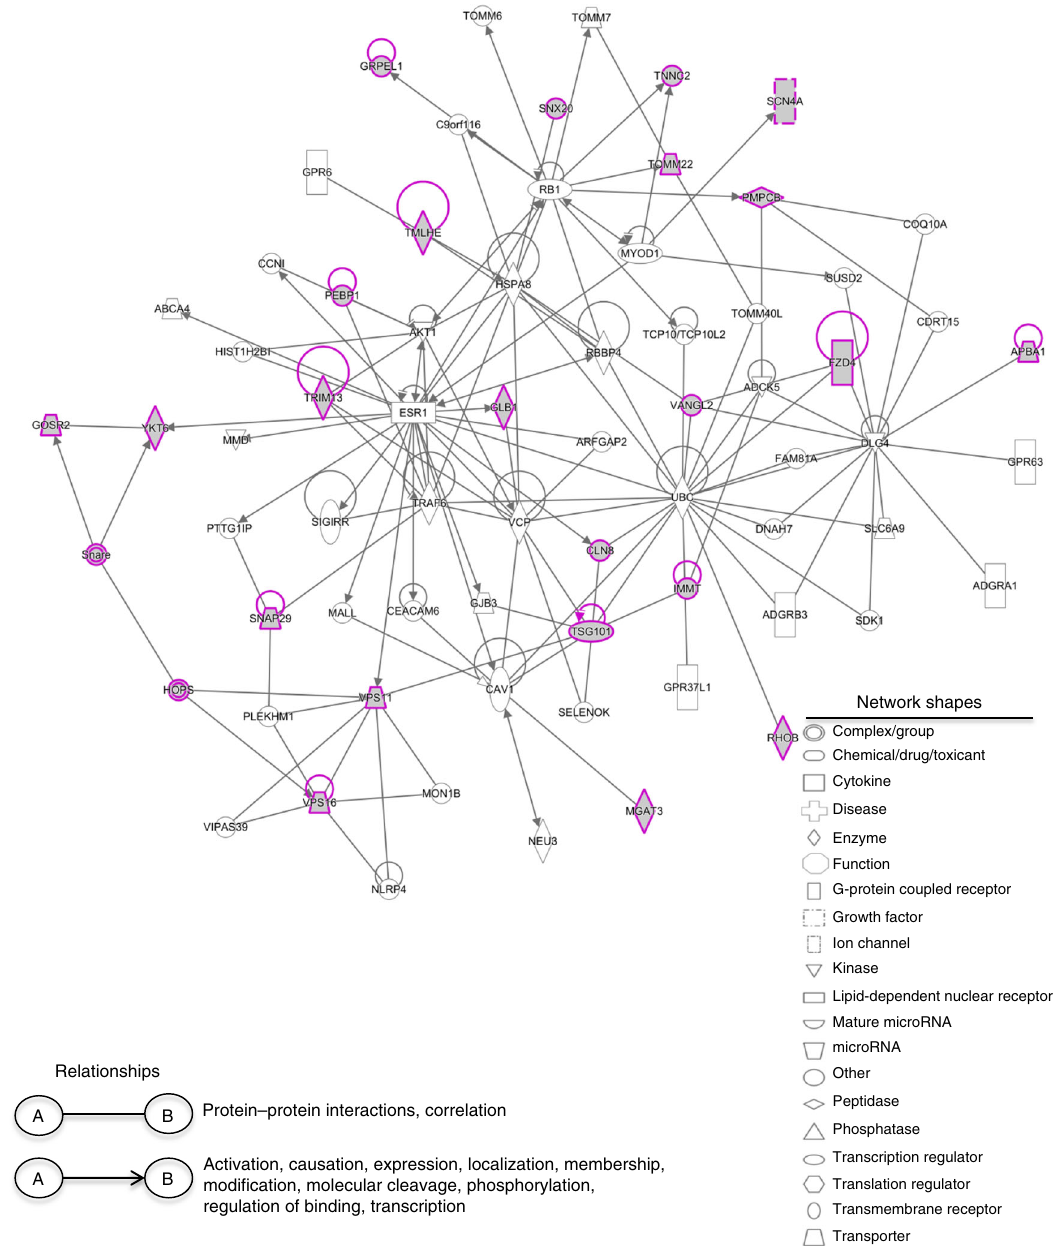
Fig. 3 Network analysis of the identi fi ed genes. Three major networks containing >5 genes were identi fi ed using IPA. Figure represents one out of three networks that include genes with functions related to cellular assembly and organization, molecular transport, and protein traf fi cking. See also Supplementary Fig.